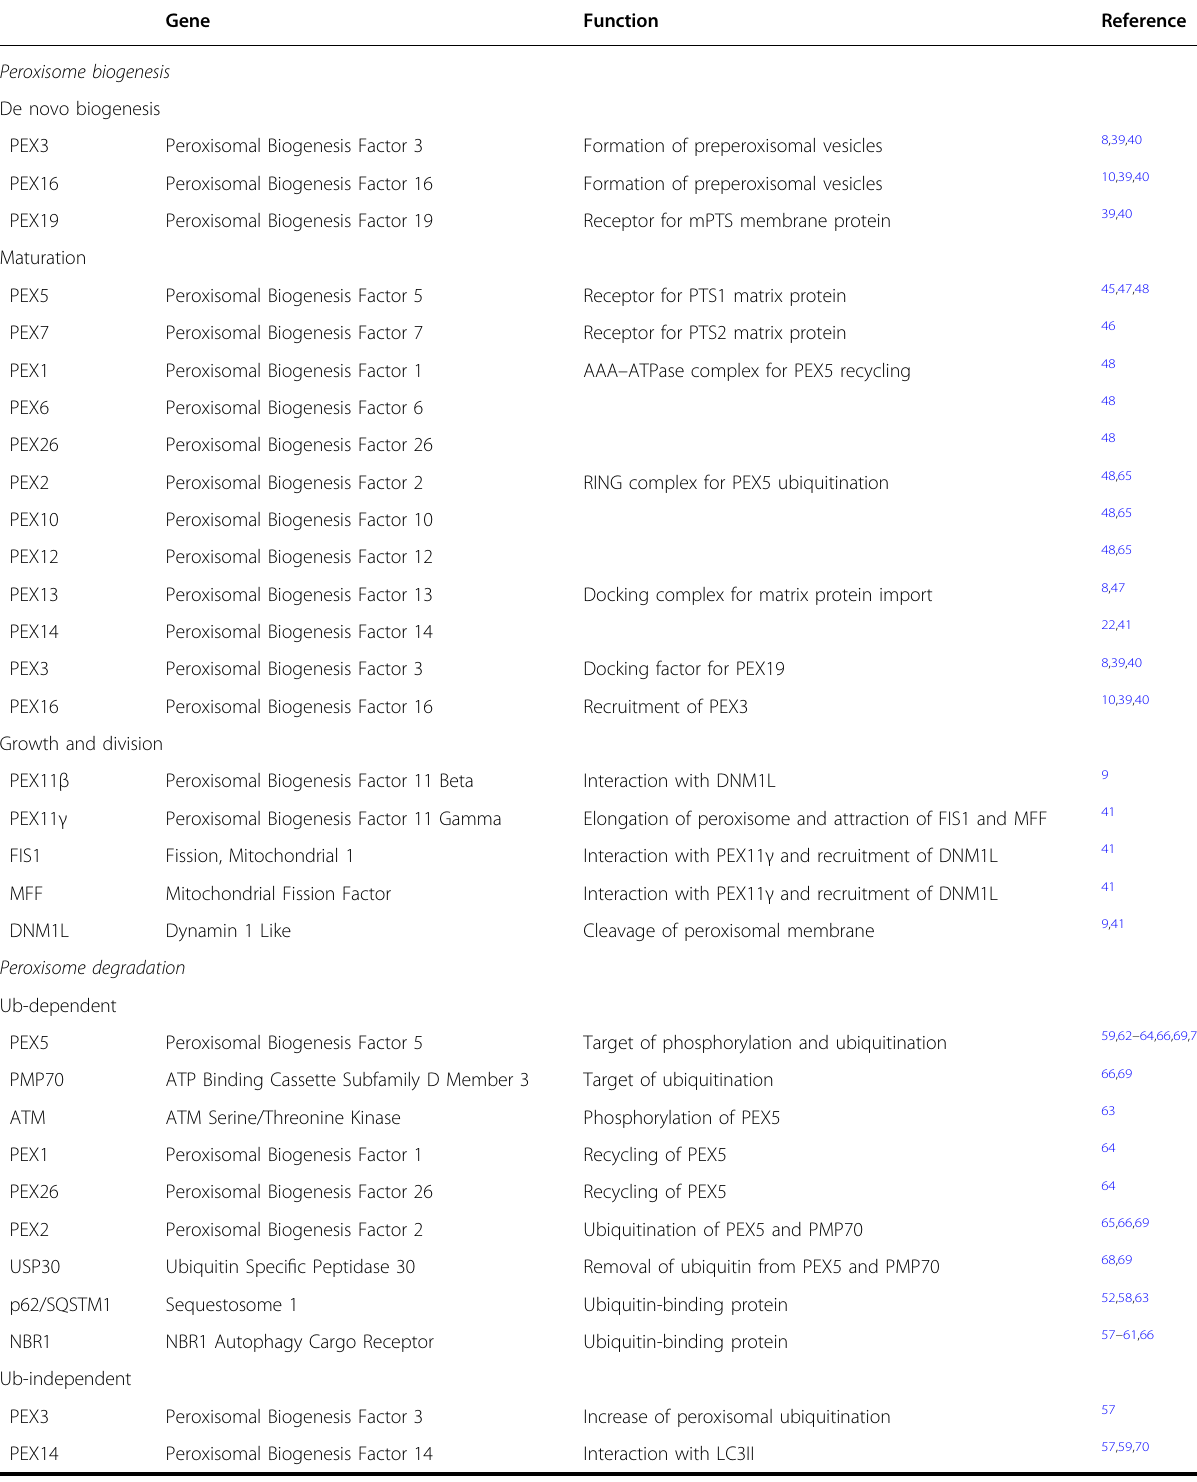
Table 1 Peroxisomal proteins involved in peroxisome quality control.